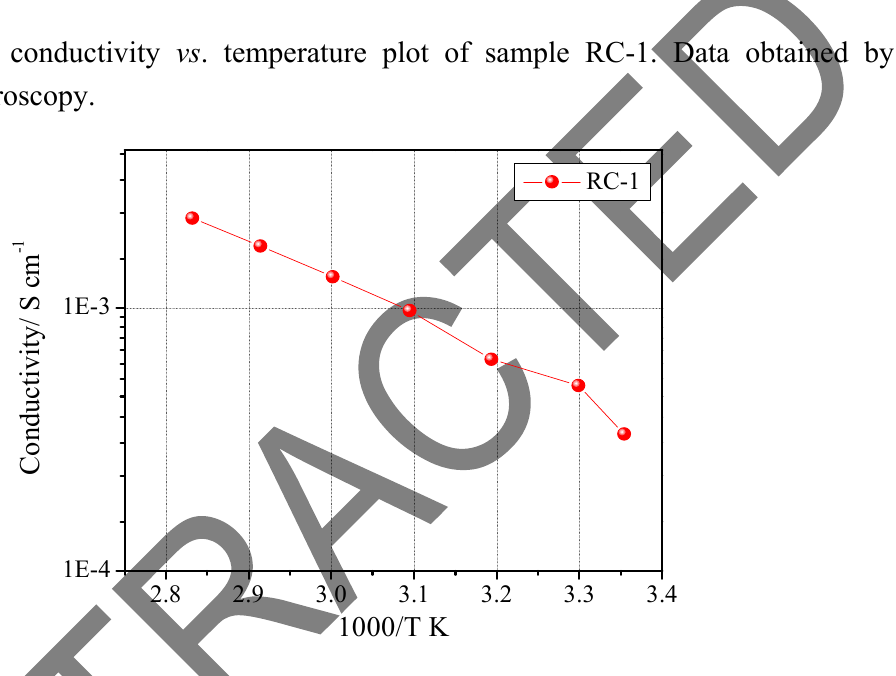
Figure 3. Ionic conductivity vs . temperature plot of sample RC-1. Data obtained by impedance